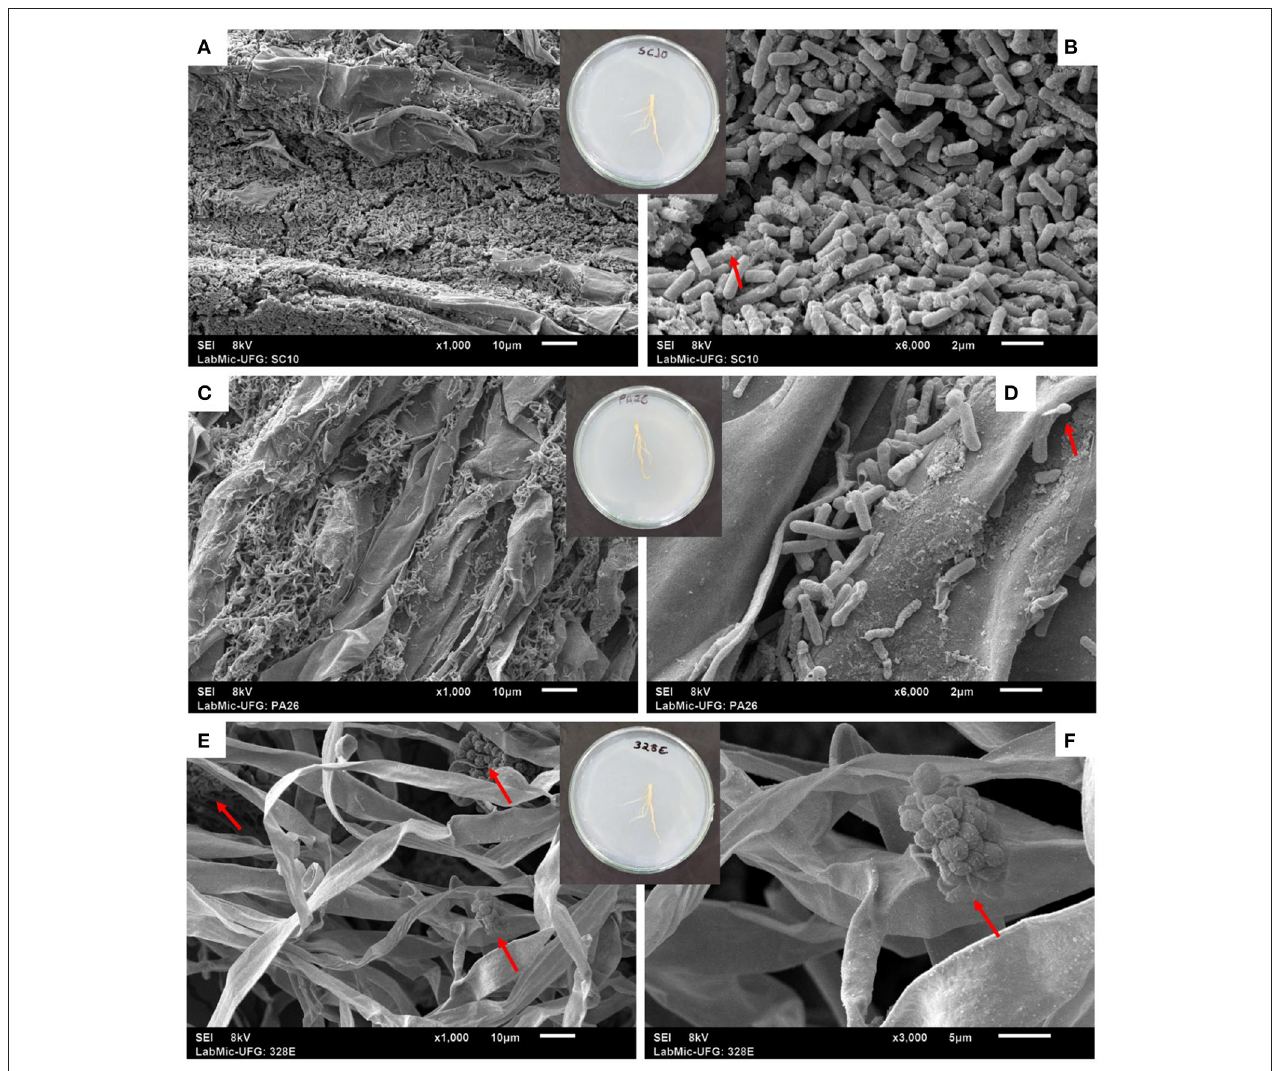
FIGURE 1 | Microscopic aspects of root colonization in soybean plants ( Glycine max) treated with the bacterial strains SC10 = Bacillus thuringiensis (A,B) and PA26 = Lysinibacillus fusiformis (C,D) , and the fungal strain 328EF = Codinaeopsis sp. (E,F) . Red arrows indicate the presence of protein crystals (B) and spores (D–F)